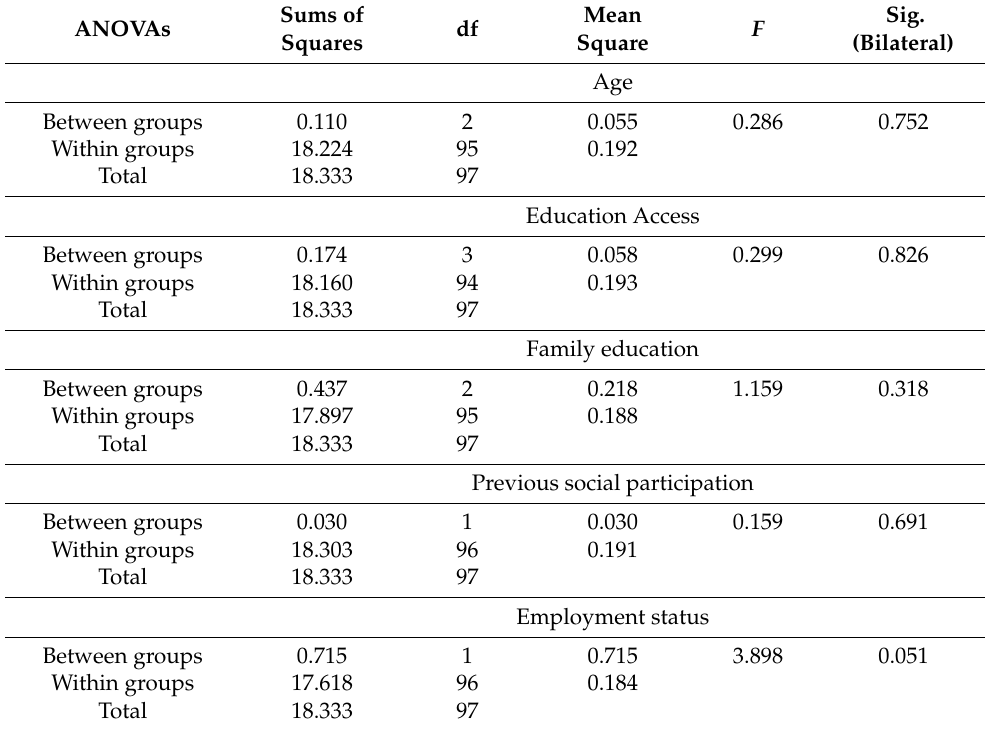
Table 5. ANOVAs SE post-test depending on